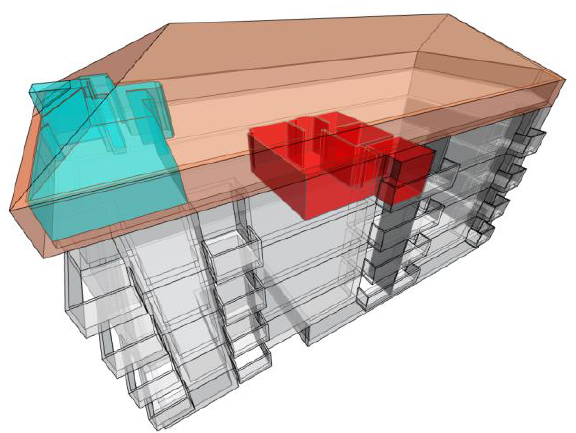
Figure 10. Part of the building modelled accordingly to the Report of particular parts – units E-44 (cyan) and E-31